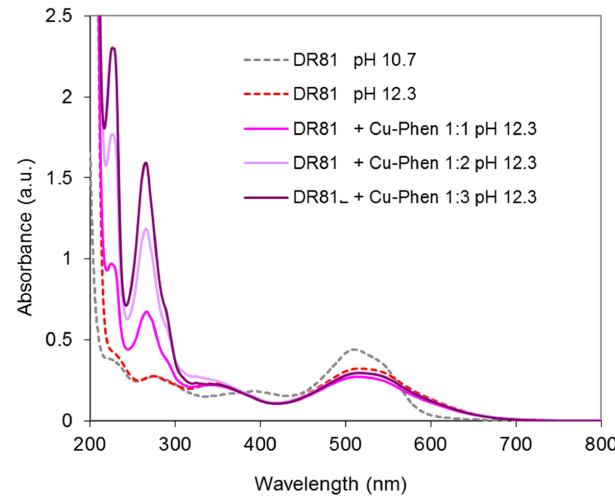
Figure 13. Absorbance spectra of the dye/copper-phenanthroline system at pH 12.3, with Cu:Phen molar ratio= 1:1, 1:2 and 1:3, DR81:Cu molar ratio= 1:1.5, and [DR81] = 10 µ M, compared to the dye alone at pH 10.7 and